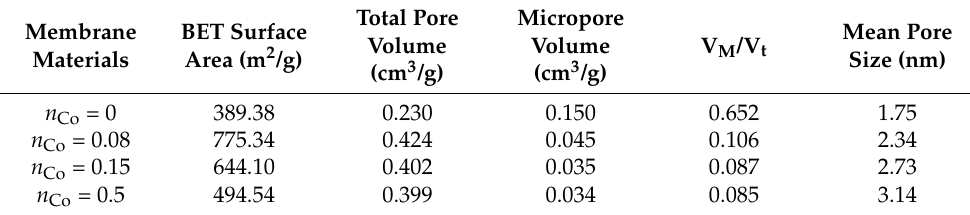
Figure 5. ( a ) N 2 adsorption-desorption isotherms and ( b ) pore size distributions of unsupported Co/MSiO 2 materials with various n Co at 400 ◦ C. Table 1. Parameters of pore structure for unsupported Co/MSiO 2 materials with various n Co after calcination at 400 ◦